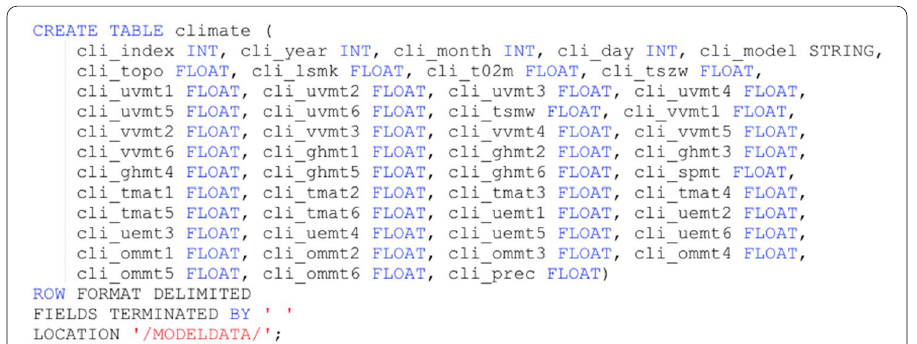
Fig. 14 The DDL command code used to create the Hive